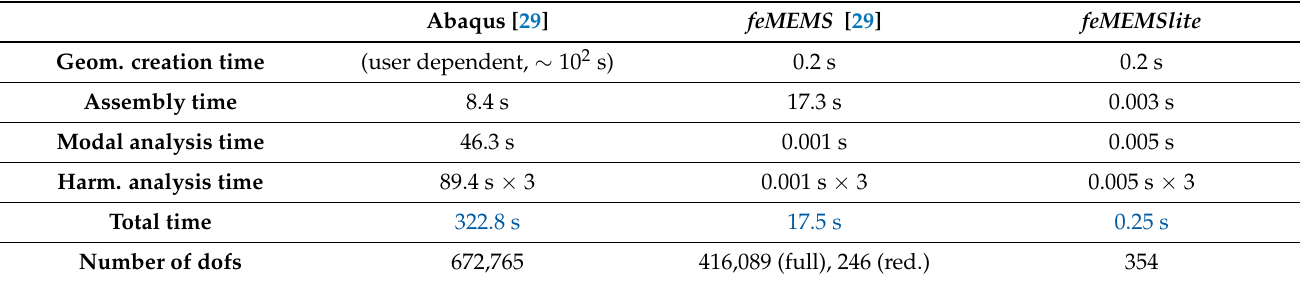
Table 1. Abaqus (HEX20), feMEMS , and feMEMSlite : run-time comparison. Data are partially taken from [29].